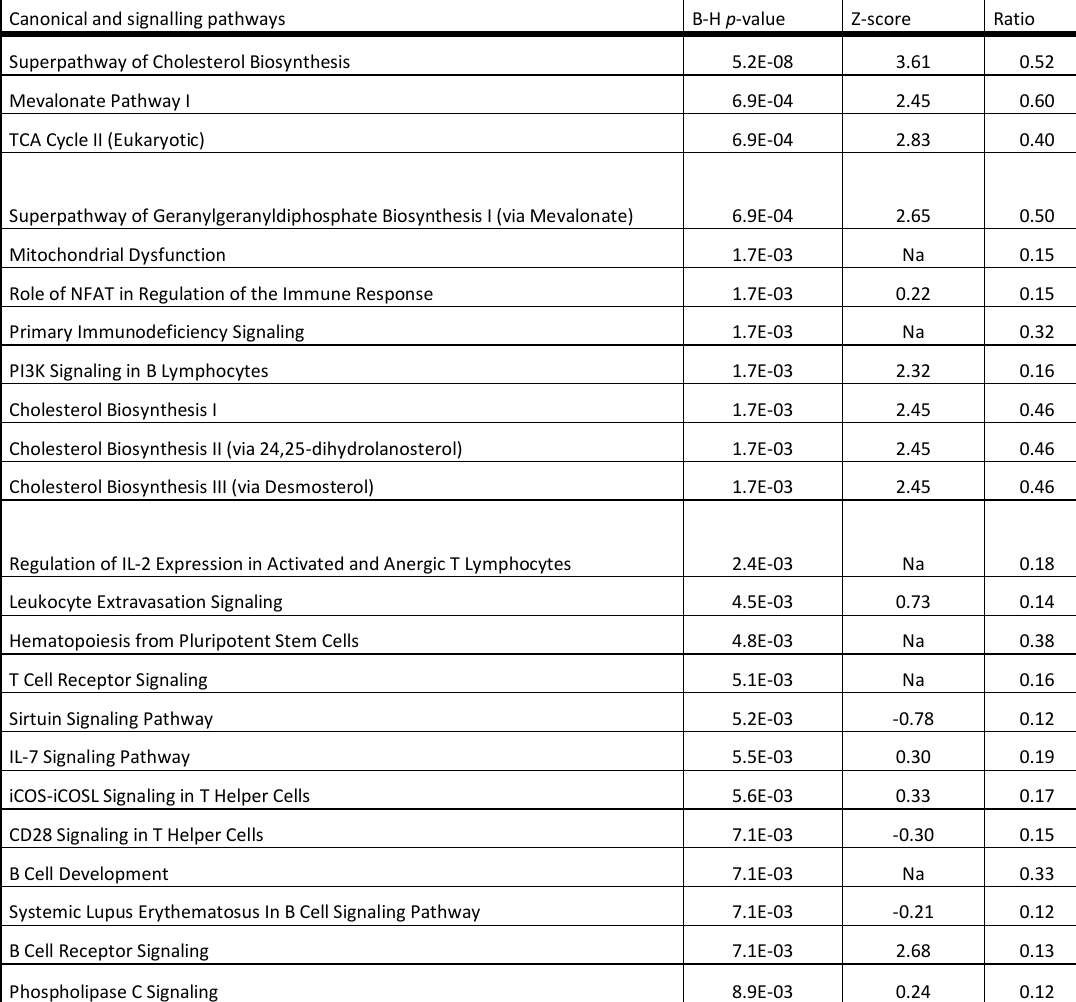
Table 2 - Canonical and signaling pathways enriched in the common DEGs in the within-breed contrasts. The name of the canonical and signaling pathways is indicated with its B-H corrected p -value, its Z-score, and the ratio between the number of DEGs and the number of genes in the pathway. Highlighted cells correspond to Z-scores with an inferred activation